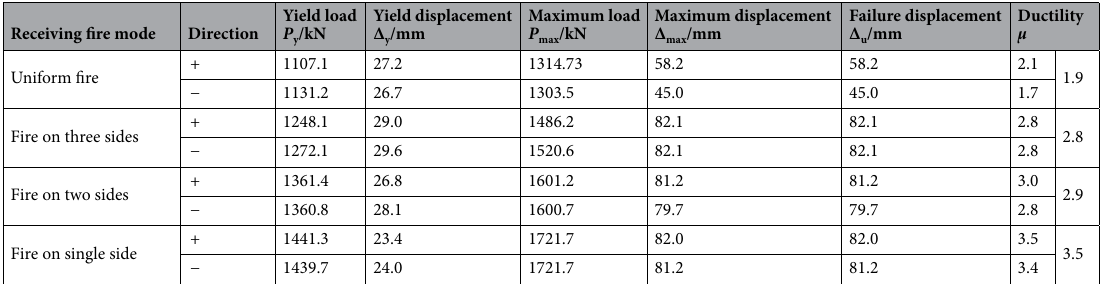
Table 4. The results of